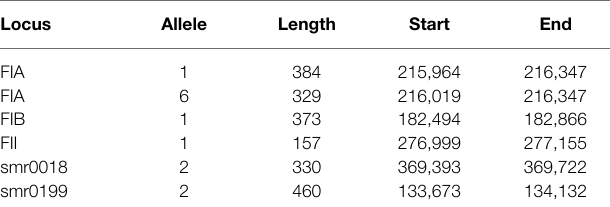
TABLE 2 | Plasmid double locus sequence typing of pMG101-A.